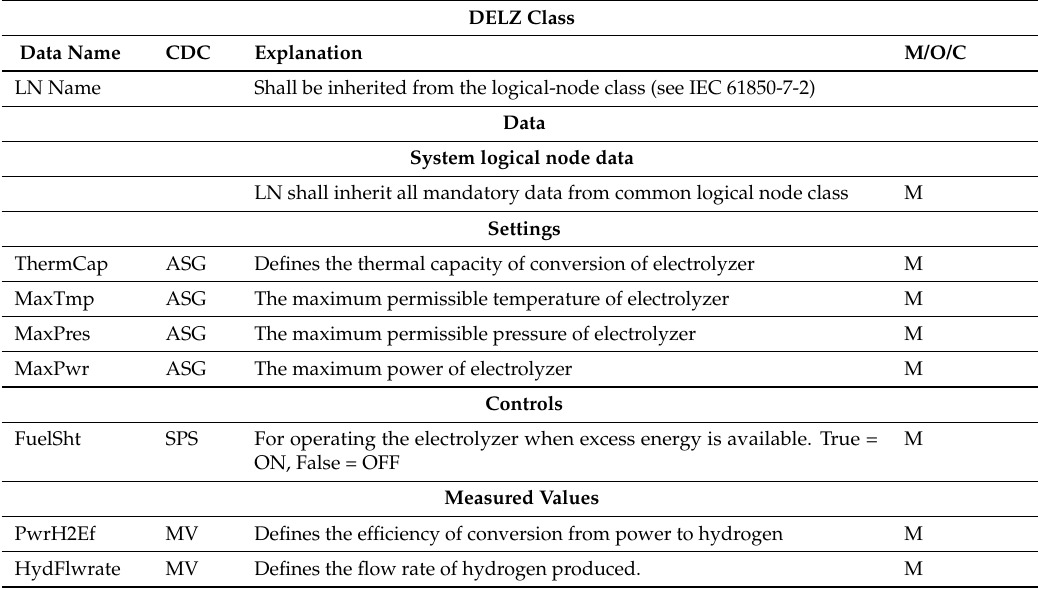
Table 6. Electrolyzer controller (DELZ) logical